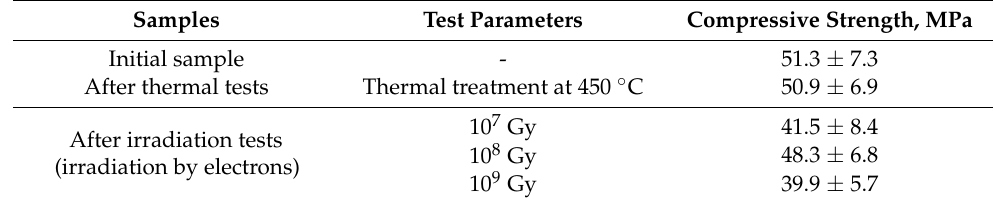
Table 4. It is shown that all samples have a high compressive strength of about 40–50 MPa and comply with the regulatory requirements for immobilized HLW (at least 9 MPa) [26]. Table 4. Compressive strength of ceramics based on bentonite clay during thermal and radiation tests.